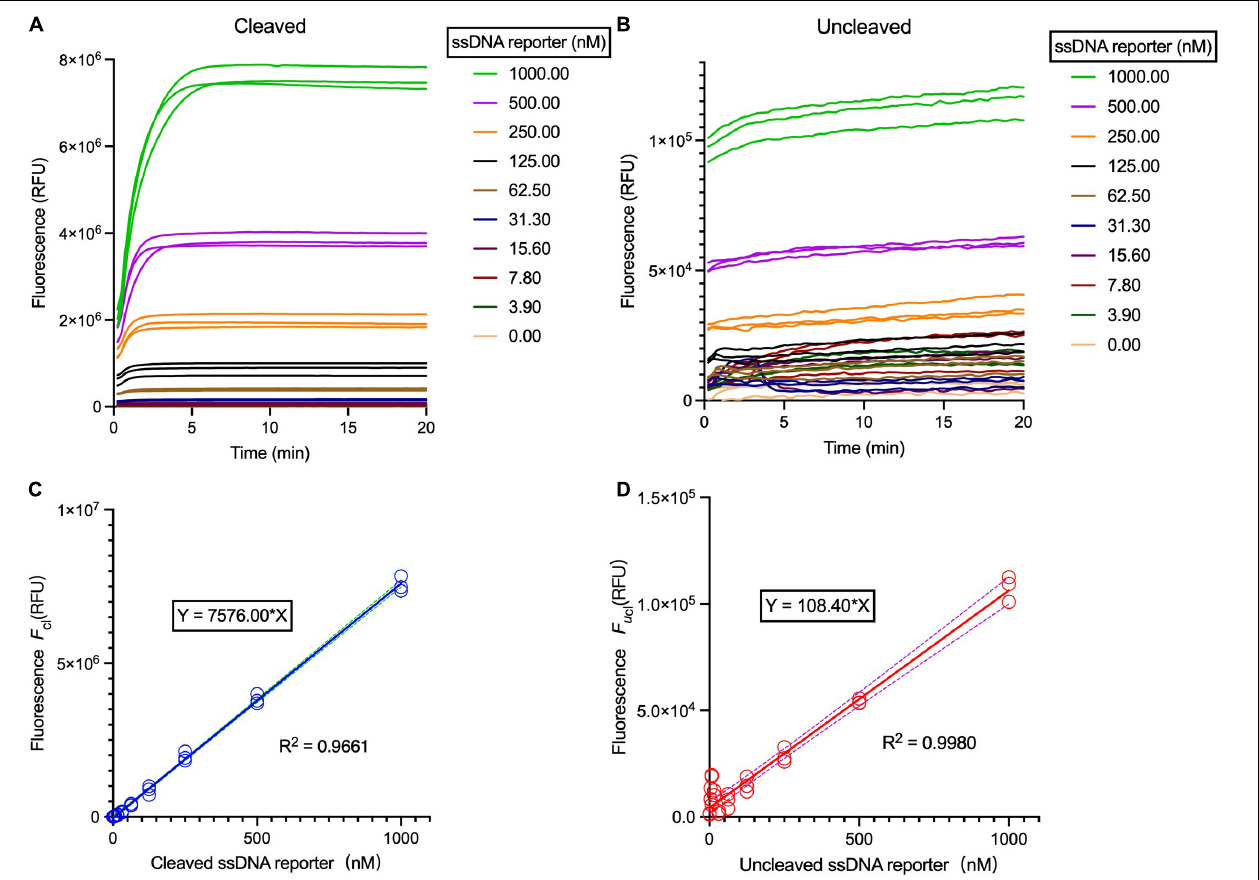
FIGURE 3 | Correlation of the relative fluorescent units (RFUs) and the FQ-reporter concentration. (A) Fluorescence curves of the Cas12a trans -cleavage reactions using different ssDNA reporter concentration. (B) Fluorescence curves of the Cas12a trans -cleavage reactions using different ssDNA reporter concentration without target. The reaction systems were comprised of 40 nM crRNA, 20 nM Cas12a, 40 nM target dsDNA, and 1 × HOLMES Buffer 1. (C) Background-subtracted fluorescence F cl versus concentration of cleaved reporters. (D) Background-subtracted fluorescence F ucl versus concentration of un-cleaved reporters. Solid lines are linear regression fits to experimental data (in symbols). Three replicates were measured for each concentration. Both cleaved and un-cleaved reporters were detected by the Applied Biosystems QuantStudio 3 machine.